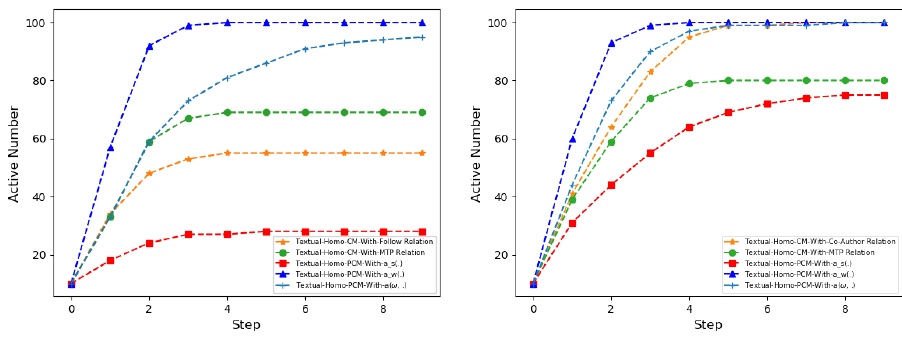
Fig. 9. Textual-Homo-PCM